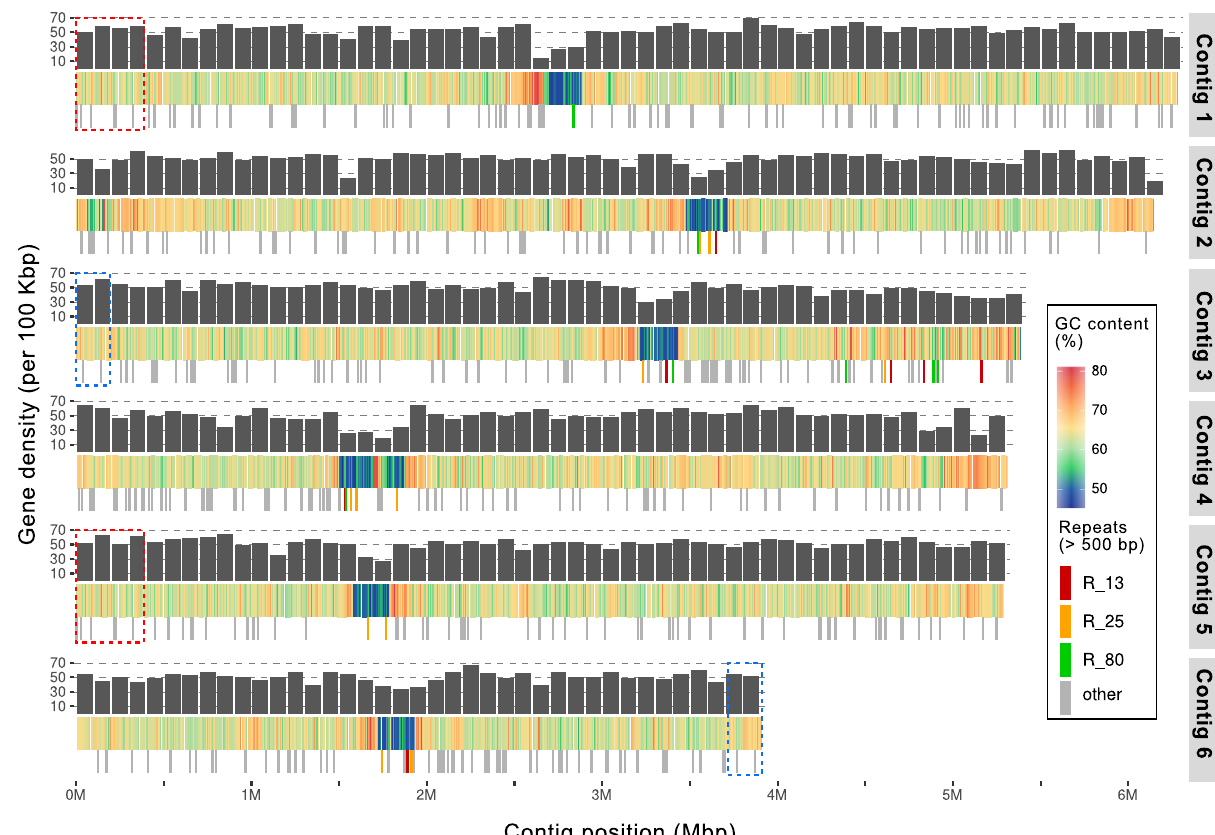
Fig. 1 Pelagomonas calceolata nuclear genome. Representation of the 6 nuclear contigs of P. calceolata . The top layer indicates the number of genes per 100 Kb (black bars), the middle layer represents the GC content in percentage over a window of 200 Kb and the bottom layer is the position of DNA repeats of more than 500 bases repeated at least fi ve times over the entire genome. Red, orange, and yellow bars indicate three different repeats in low-GC regions present in at least three different contigs. Dashed red and blue rectangles are duplicated chromosomic regions.